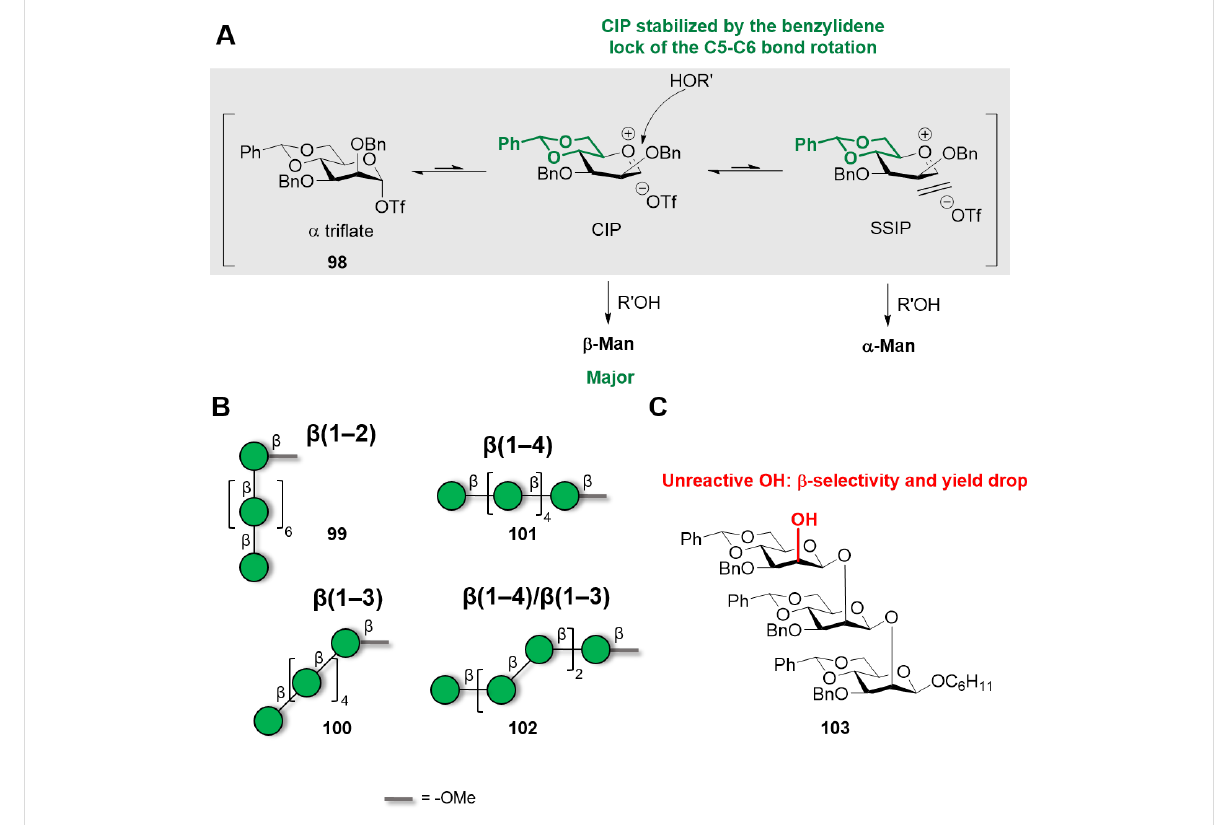
Figure 7: PG stereocontrol strategy to obtain β -mannosides. A) The mechanism of the β -mannosylation reaction is thought to proceed through a con- tact ion pair (CIP) in which the triflate anion shields the α -face favoring the nucleophile attack from the β -face. The solvent separated ion pair (SSIP) scenario is disfavored due to the benzylidene group locking the C5–C6 bond in the tg conformation which destabilizes the oxocarbenium ion. For a thorough explanation of the mechanism we refer to the original publication [289]. B) Examples of β -mannosides synthesized using the 4,6- O -benzyl- idene directed β -mannosylation strategy. C) Chain elongation beyond the trisaccharide level for β (1–2)-analogues presented a significant drop in yield and β -stereoselectivity due to the conformation of acceptor 103